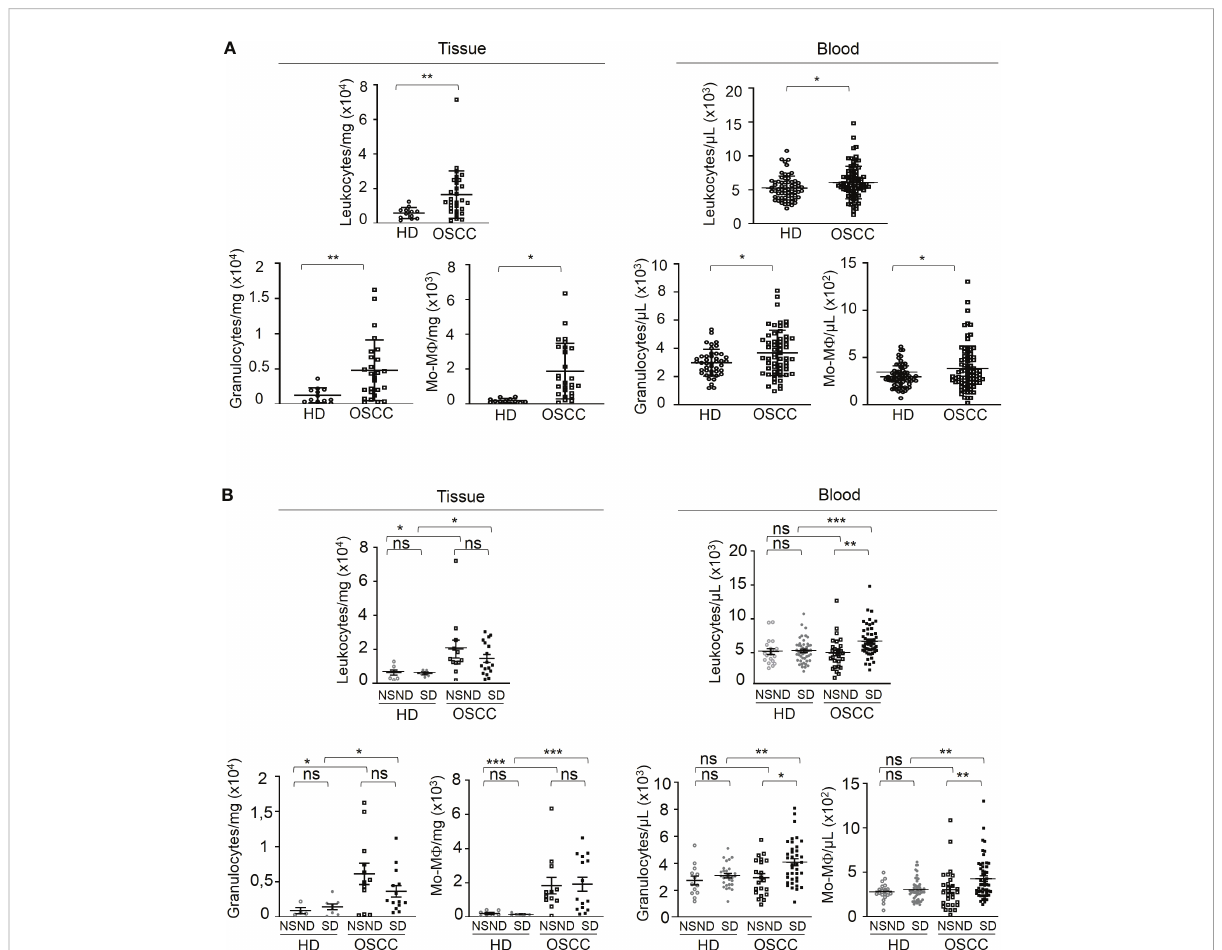
FIGURE 2 Analysis of the innate immune contents of tumor tissue and blood samples from OSCC patients and healthy donors according to risk factors (SD vs NSND). Data are presented either as absolute number of cells per mg of tumor or gingival tissue, or as absolute number of cells per µL of blood. (A) Analysis of leukocytes, granulocytes and monocytes-macrophages (Mo-M f ) of OSCC patients and healthy donors (HD); data from OSCC patients ( □ , 44 tumors and 87 blood samples from OSCC patients) were compared to those obtained from healthy donors ( ○ , 18 normal gingival tissues and 53 blood samples). (B) Analysis of leukocytes, granulocytes and monocytes-macrophages (Mo-M f ) of OSCC patients and healthy donors depending on risk factors exposition. Data from SD ( ■ ) and NSND ( □ ) OSCC patients were compared to those obtained from SD ( ● ) and NSND ( ○ ) healthy donors. 14 tumors and 28 blood samples from NSND OSSC patients and from 30 tumors and 59 blood samples from SD OSCC patients, and 9 normal gingival tissues and 19 blood samples from NSND healthy donors and from 9 normal gingival tissues